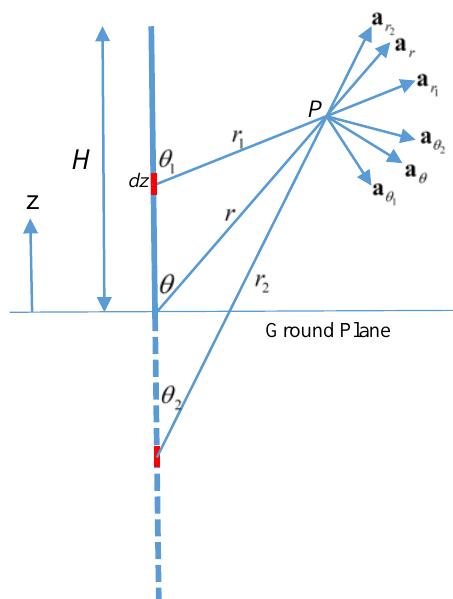
Figure 2. Geometry pertinent to the evaluation of electromagnetic fields from the lightning return stroke channel. The diagram also shows the vectors necessary for writing down the electromagnetic fields from a small channel element. The vector a ϕ is in the direction of a r × a θ .